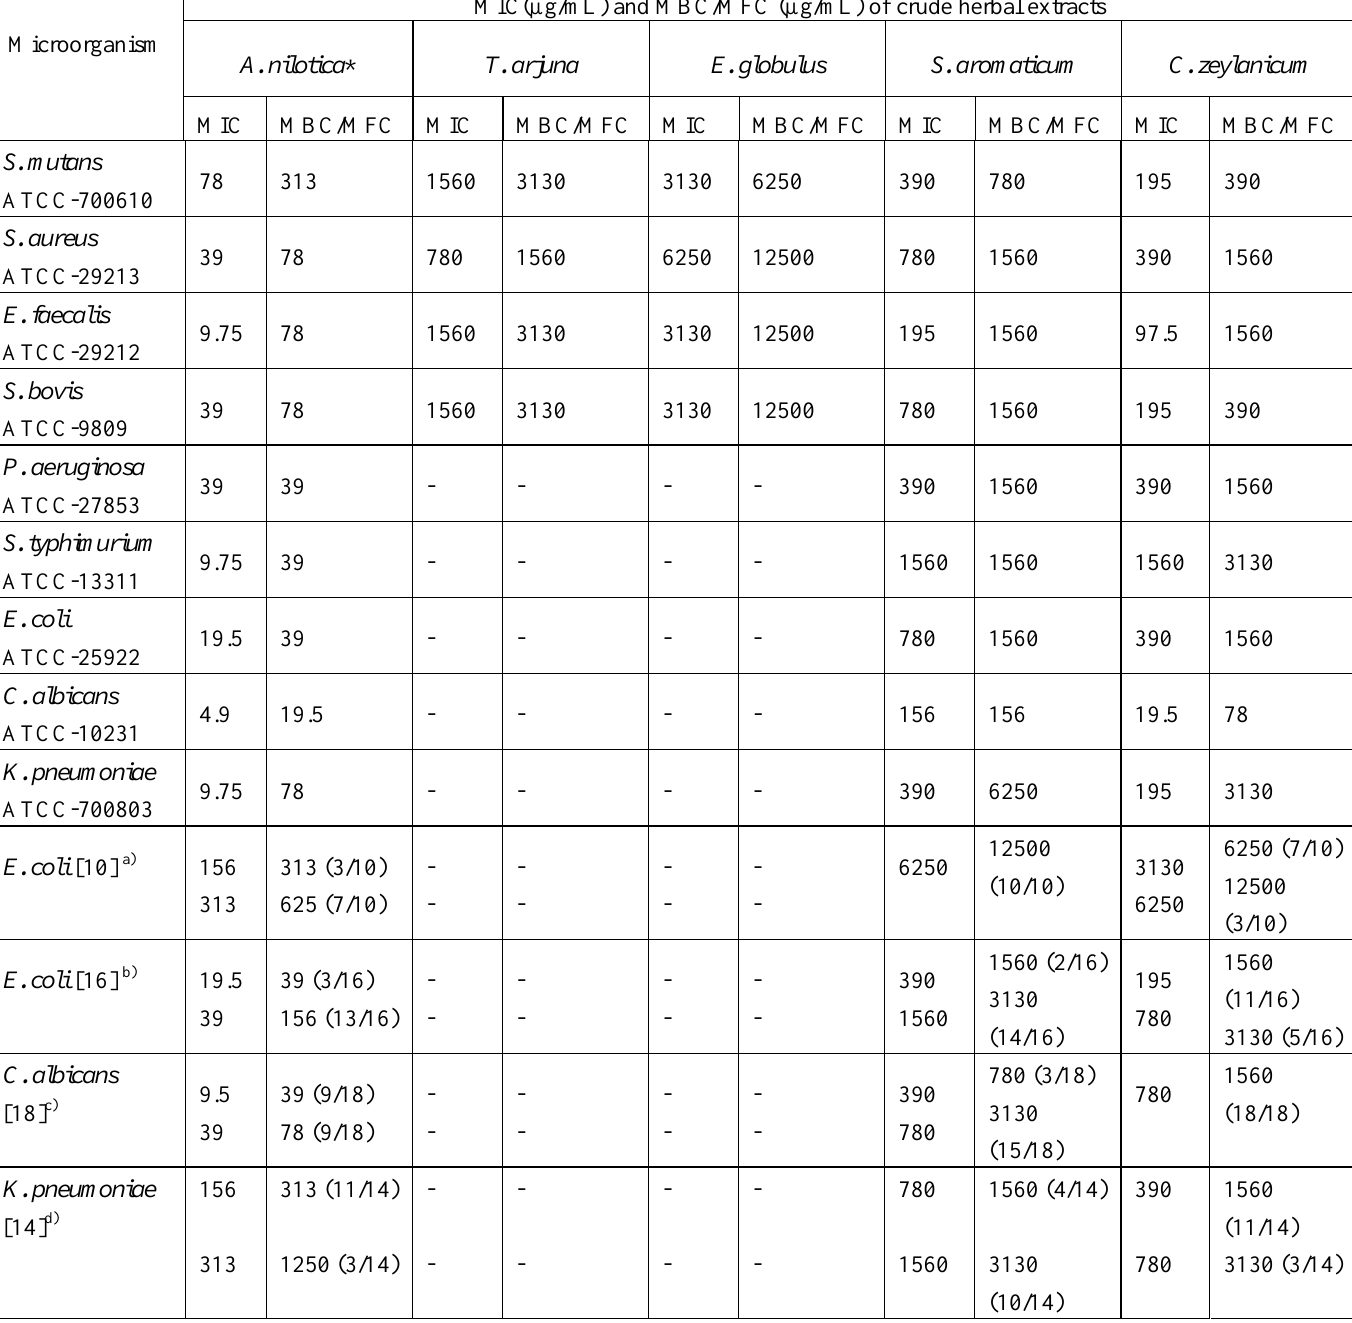
Table 2 . MIC and MBC/MFC values for crude extracts of plant parts against Multi-Drug Resistant strains of Nosocomial and Community Acquired Infections and susceptible standard